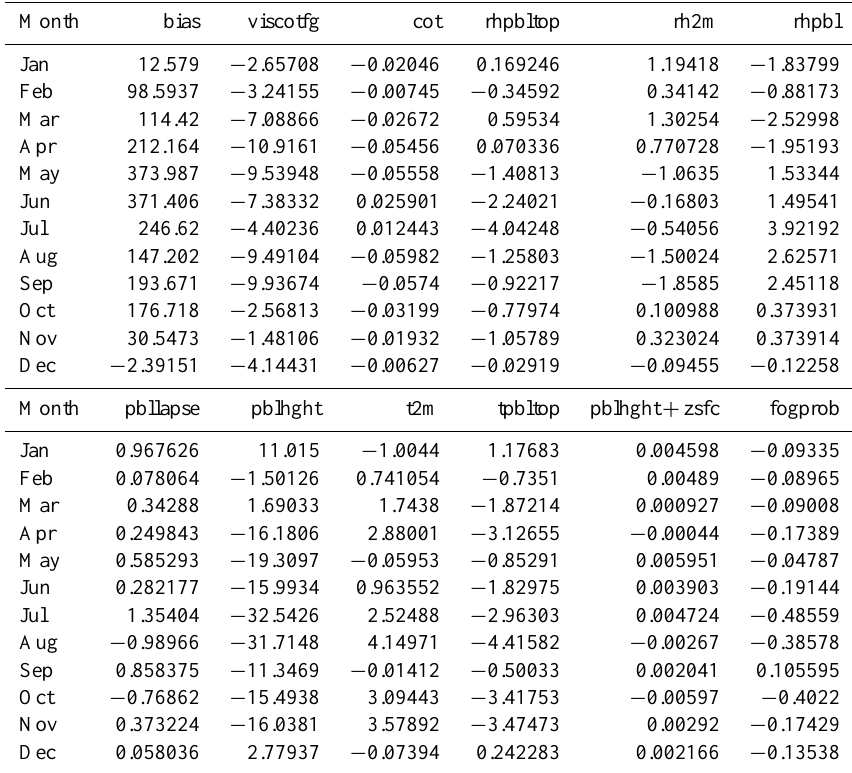
Table 2. Fog/low cloud multiple regression coefficients for bias, first guess fog visibility (viscotfg), cloud optical thickness (cot), relative humidity at top of the PBL (rhpbltop), 2m relative humidity (rh2m), mean PBL relative humidity (rhpbl), PBL lapse rate (pbllapse), PBL height (pblhght), 2m temperature (t2m), temperature at the top of the PBL (tpbltop), PBL height plus surface height (pblhght + zsfc), and fog/low cloud probability (fogprob)